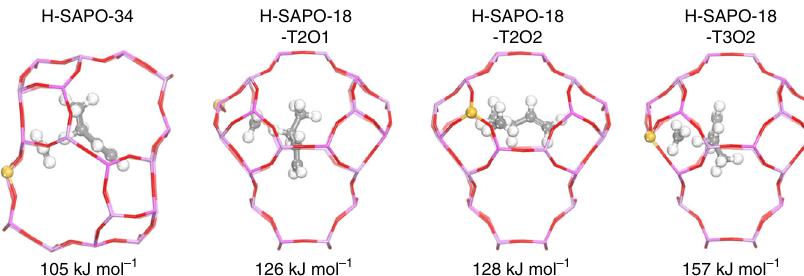
Fig. 6 Hydride transfer barrier. Calculated hydride transfer barrier between methoxide and 1-butene in H-SAPO-34 and H-SAPO-18